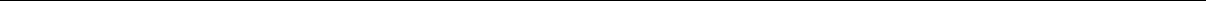
Fig. 1 Genome organization in Plasmodium parasites. a Schematic overview of the parasite life cycle, with the samples generated in this study highlighted in blue and stages available from a previous study 16 shown in orange. b ICE-normalized contact count matrices (top row) and fi t-hi-c p -value matrices (bottom row) at 10 kb resolution of chromosome 7 for P. falciparum stages and chromosome 11 for P. vivax sporozoites. The boxed value indicates the maximum contact count (top row) or minimum p -value (bottom row). In all other fi gures comparing different stages, the contact counts were subsampled to the same total. Virulence clusters are indicated by yellow boxes, the centromere location by a dashed black line, and unmappable regions by gray in these and all other heatmaps. c Models of the consensus three-dimensional organization of the P. falciparum genome in stage II/III gametocytes, stage IV/V gametocytes, and salivary gland sporozoites, with light blue spheres indicating centromeres, white spheres indicating telomeres and green spheres indicating the location of virulence gene